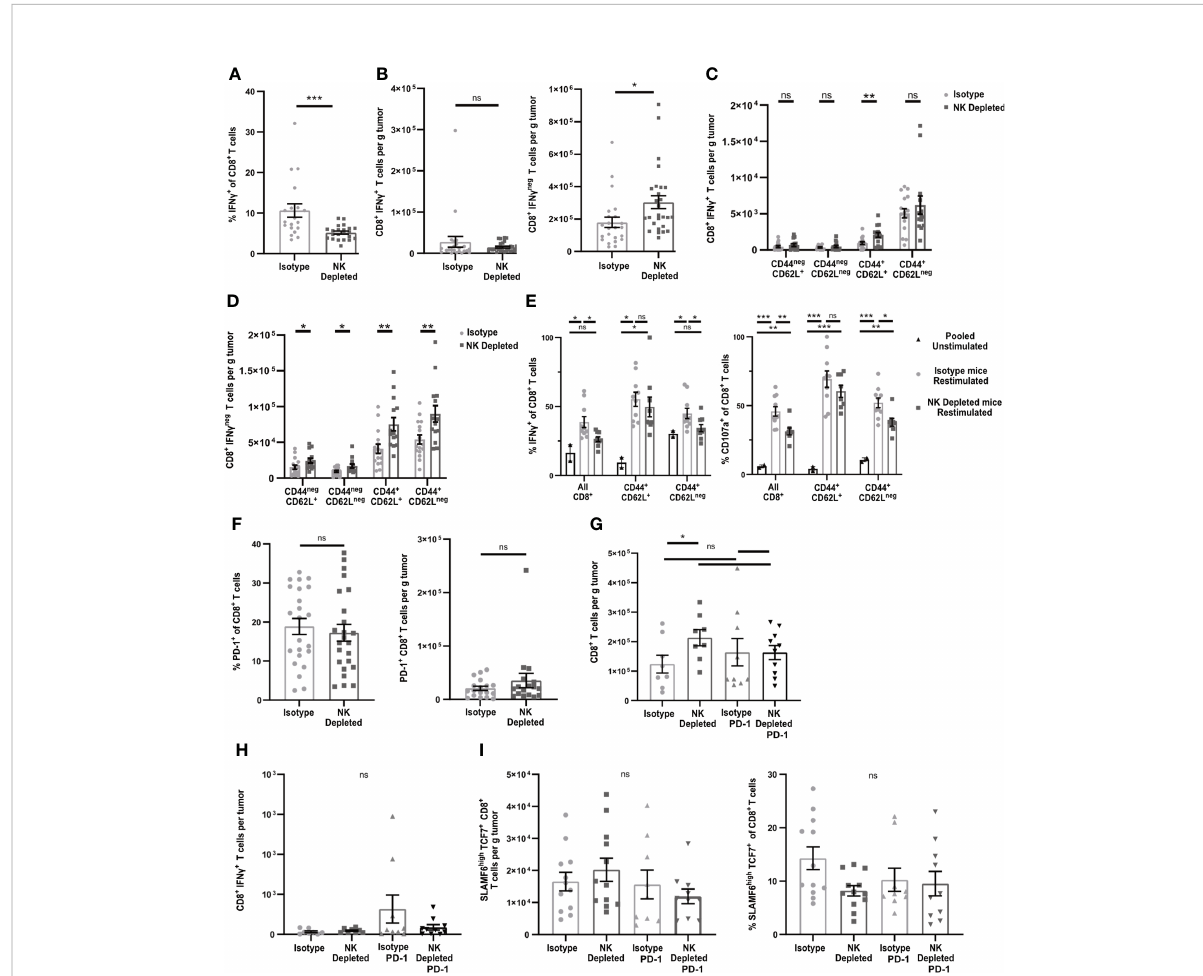
FIGURE 3 Early-stage tumors from mice lacking NK cells have increased numbers of dysfunctional but non-exhausted CD8+ T cells. B16-ova tumors were implanted into WT B6 mice treated with isotype control or anti-NK1.1 depleting antibody on D-2, D1, and D4, and harvested on D7. (A – D, F – I) Single cell suspensions were enriched for CD45+ cells using MACS Beads and analyzed by fl ow cytometry. (A – D, H) Mice were treated with BFA for cytokine analysis 4-6 hours prior to tumor harvest. (E) CD8+ cells were isolated using MACS beads and restimulated with anti-CD3/28 beads and labeled with anti-CD107a fl uorescently labeled antibodies overnight, with unstimulated T cells pooled from all tumors as a control. BFA was added for the fi nal 4-6 h to block cytokine secretion. (G – H) Isotype-treated or NK depleted mice were treated with anti-PD-1 or isotype control starting on D3 after tumor implantation. (A – D, F – I) Data points represent a single tumor and mean per group with error bars representing SEM. Data are from: (A – B) 6 experiments; (C – D) 4 experiments; (E) 2 experiments, with unstimulated controls pooled from all tumors in each individual experiment. (F) 5 experiments; (G – H) 3 experiments. Statistics: (A – D, F) Unpaired Student ’ s T test with Welch ’ s correction; (E, G – I) One-way Anova with Tukey ’ s posttest. *p < 0.05; **p < 0.01; ***p < 0.001; ns, not signi fi